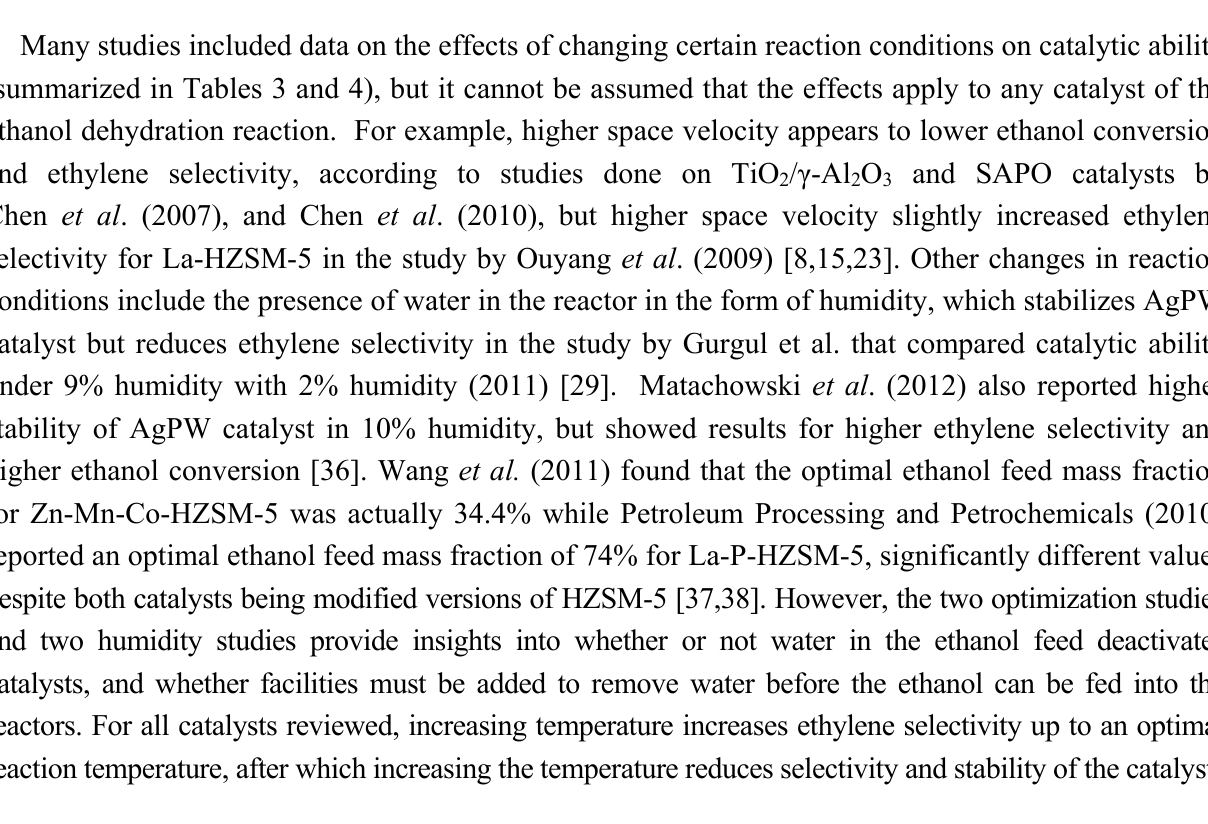
Table 3. Effect of space velocity on catalytic ability of ethanol dehydration